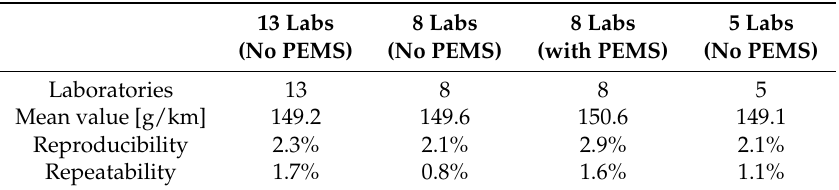
Table 2. Bag CO 2 [g/km] mean emissions, repeatability and reproducibility of the inter-laboratory exercise for different combinations of